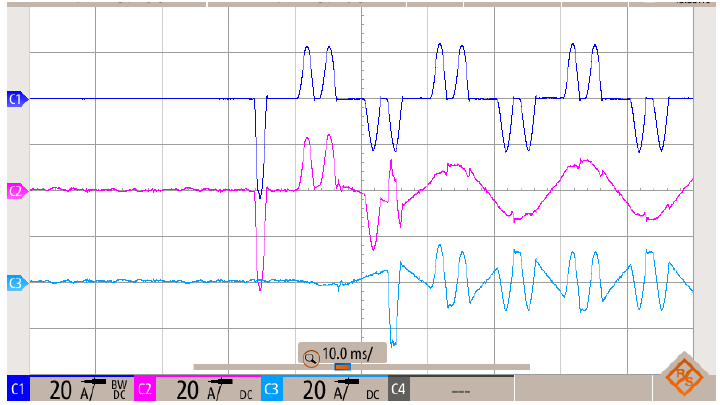
Figure 14. Operation of NPC T-type APF during transient.